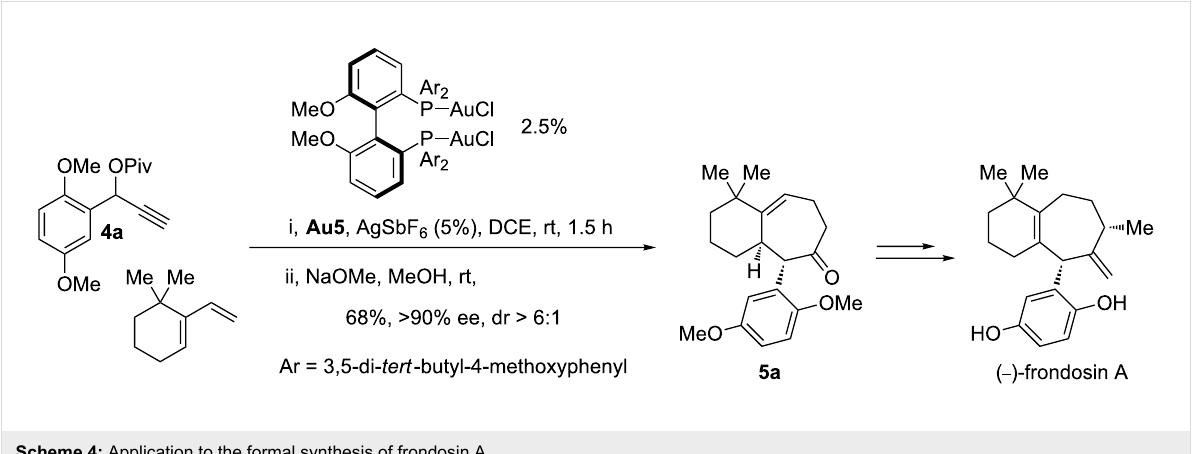
Scheme 4: Application to the formal synthesis of frondosin